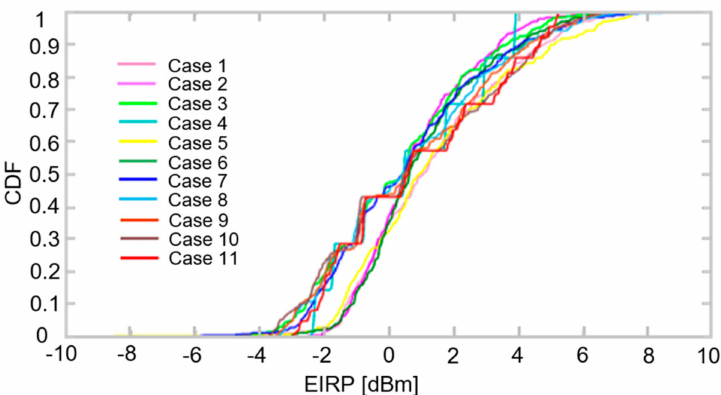
Figure 11. Effective isotropic radiated power ( EIRP ) of cumulative distribution functions (CDFs) comparison within 70 ◦ to 100 ◦ .